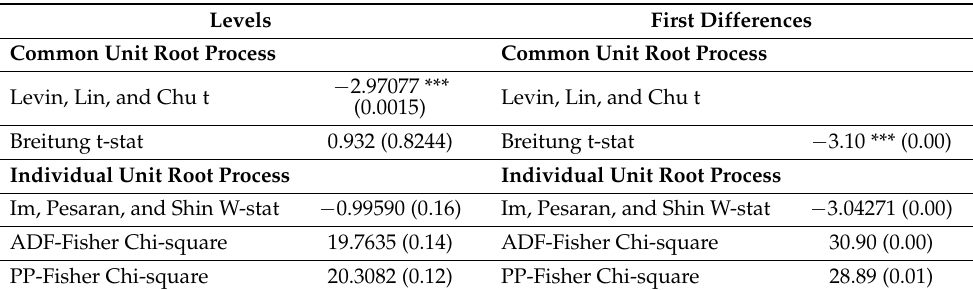
Table 1. Results of the panel unit root tests. Levels First Differences Common Unit Root Process Common Unit Root